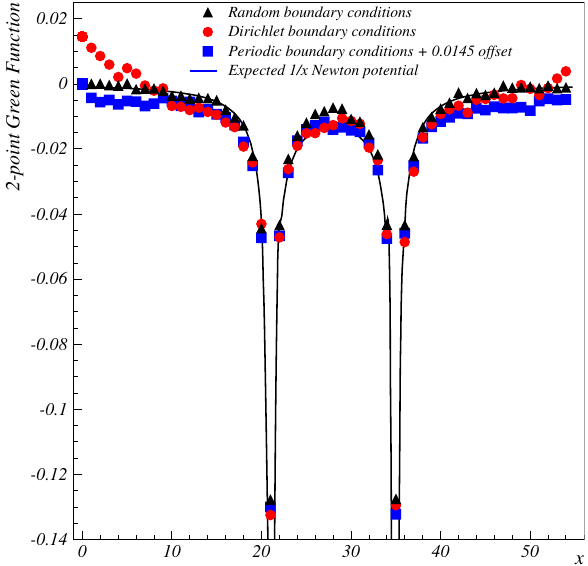
Fig. 10 Same as Fig. 9 but using the full ( g φ∂ μ φ∂ μ φ + g 2 φ 2 ∂ μ φ∂ μ φ ) theory Lagrangian, Eq. (12). The results are essentially the same for Dirichlet and random field boundary conditions. They are qualitatively similar for periodic boundary conditions but quantitatively, the force between the two sources differs by up to a factor of two. The cause of this difference originates from spurious effects in the periodic boundary case due to the long correlation length allied with the infinite repetitions of the